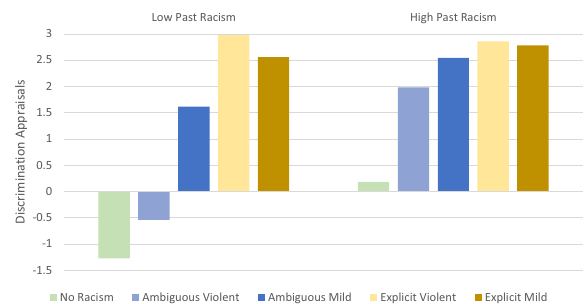
Fig. 6 Moderating effects of past racism experiences on Blacks ’ appraisals of whether the video scenarios were discriminatory as a function of racist cues presented in each of the fi ve conditions. When fewer past experiences of racism were reported (1 SD below the mean), discrimination appraisals were greatest when racist cues were explicit. As past exposure to racism increased (1 SD above the mean), Black participants were more likely to regard ambiguous events as constituting discrimination.